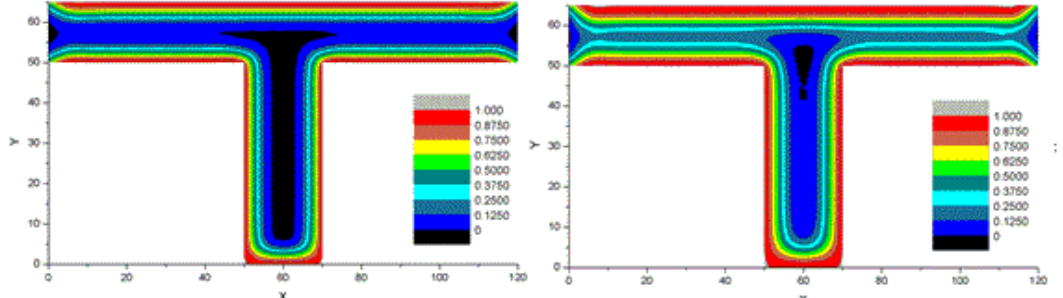
Figure 13 – Isoprobability maps for 25 years and 50 years. High environment aggressiveness.